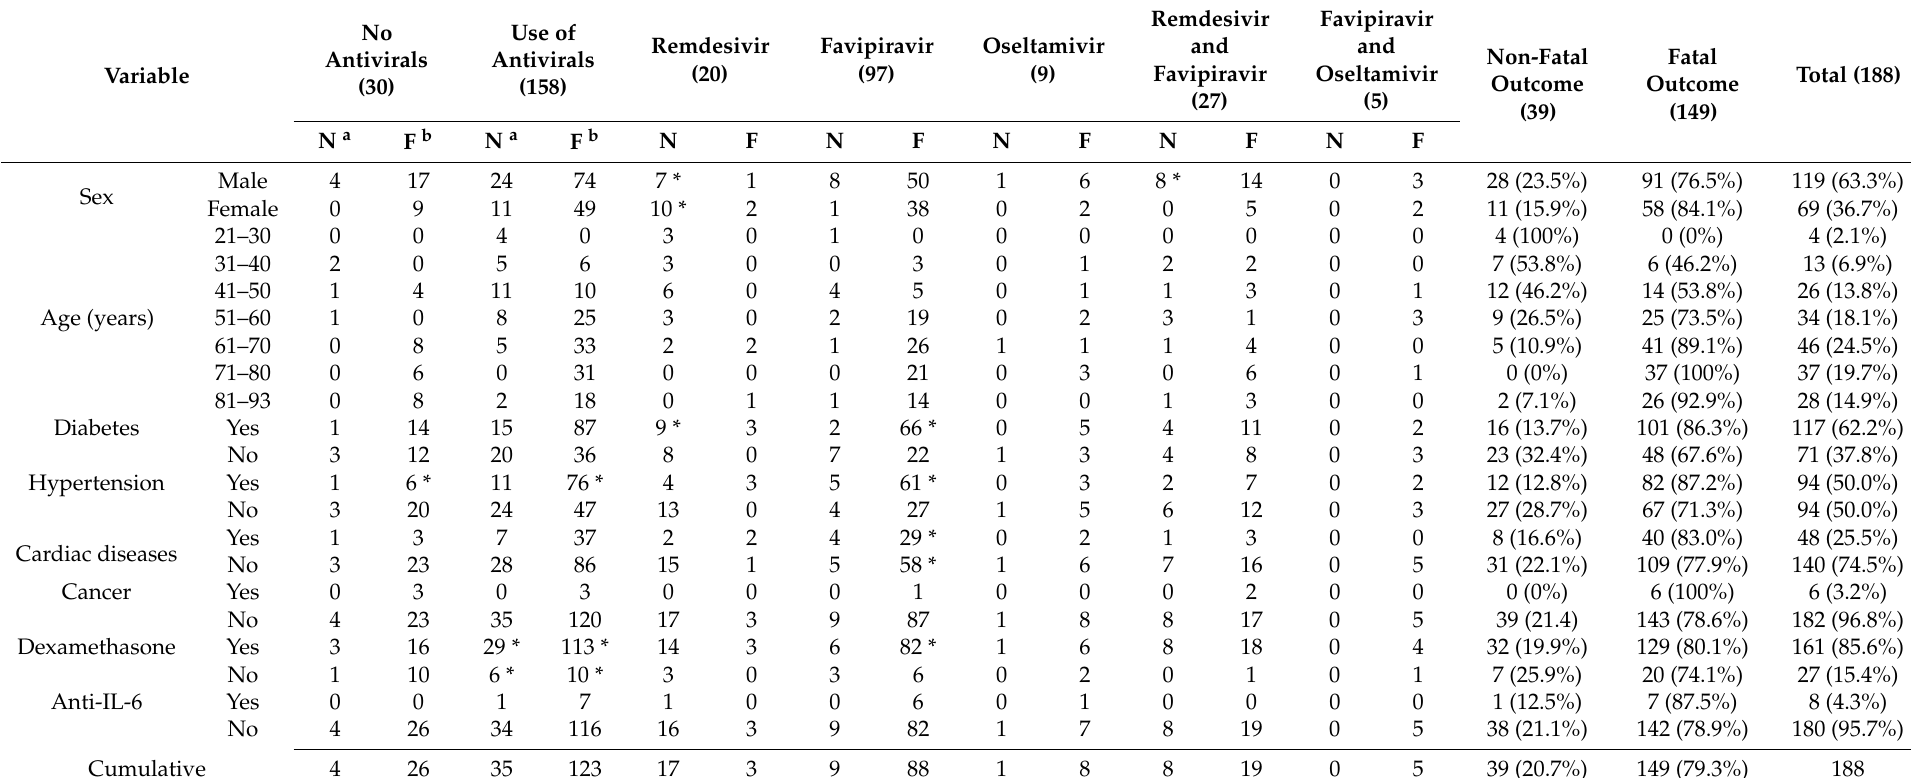
Table 2. Effects of different variables on the clinical outcomes of using antiviral regimens in critical COVID-19